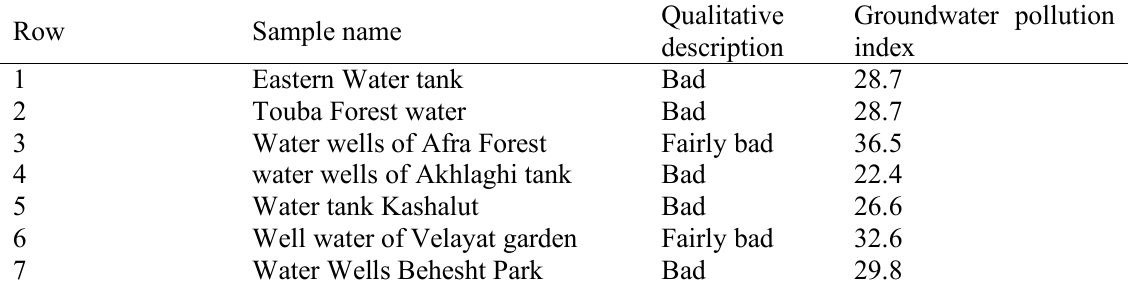
Table 10 . Indicator of pollution by demarcation of underground